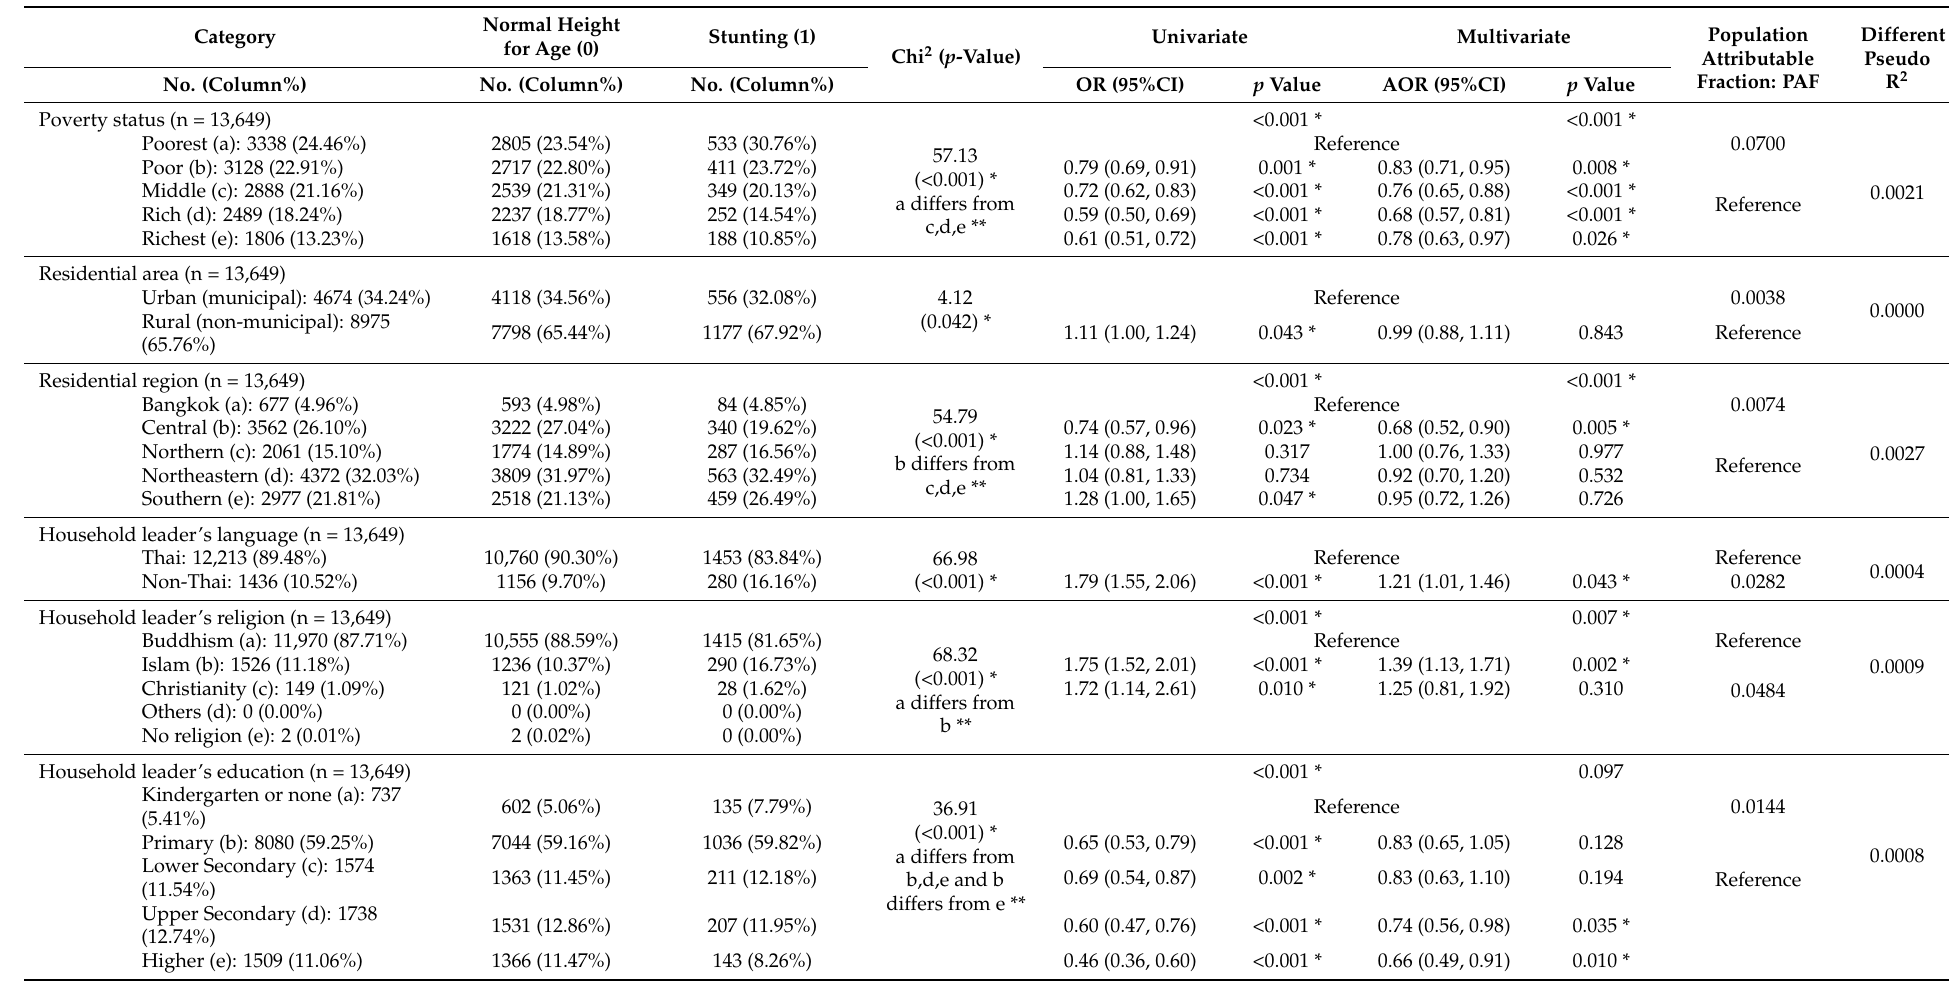
Table 2. The proportion of stunting among children under 5 years by socioeconomic status (SES), association between being stunted and socioeconomic status, and effect of each SES as illustrated by the PAF and different pseudo-R-squared